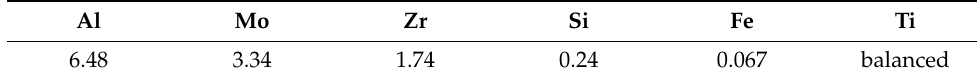
Table 1. Chemical composition of the Ti-6.5Al-3.5Mo-1.5Zr-0.3Si alloy (wt %).